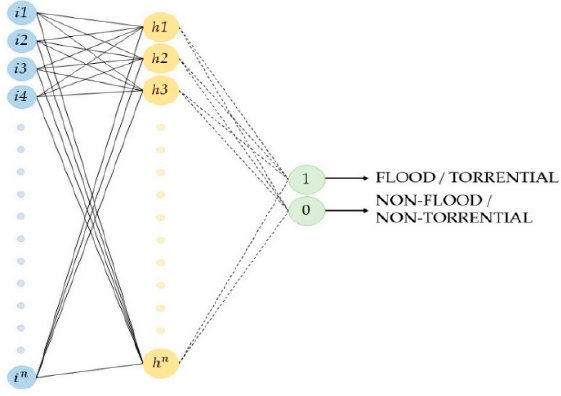
Figure 5. Multilayer perceptron neural network